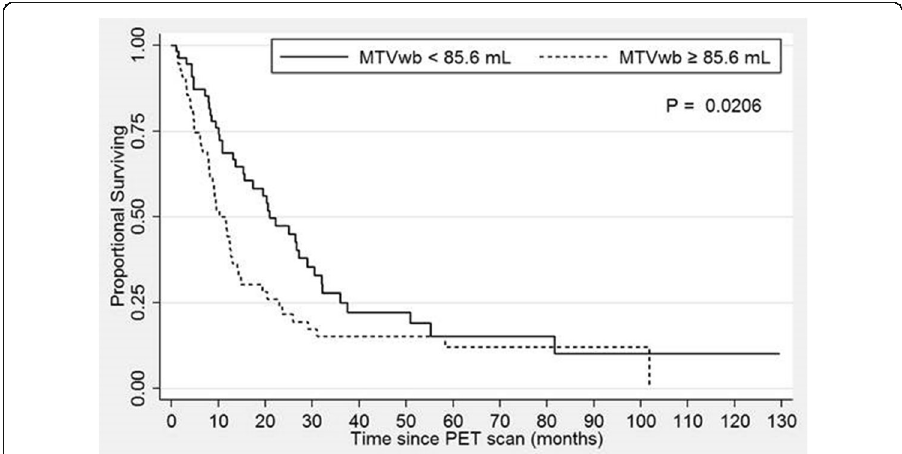
Fig. 2 Kaplan-Meier overall survival curves of the training dataset of 110 patients with TNM Stage 3B NSCLC, stratified by the median MTVwb of 85.6 mL. The dashed line indicates patient group with MTVwb greater than or equal to 85.6 ml with median OS of 9.5 months. The solid line indicates patient group with MTVwb less than 85.6 ml with median OS of 17.3 months. The difference is statistically significant with p =